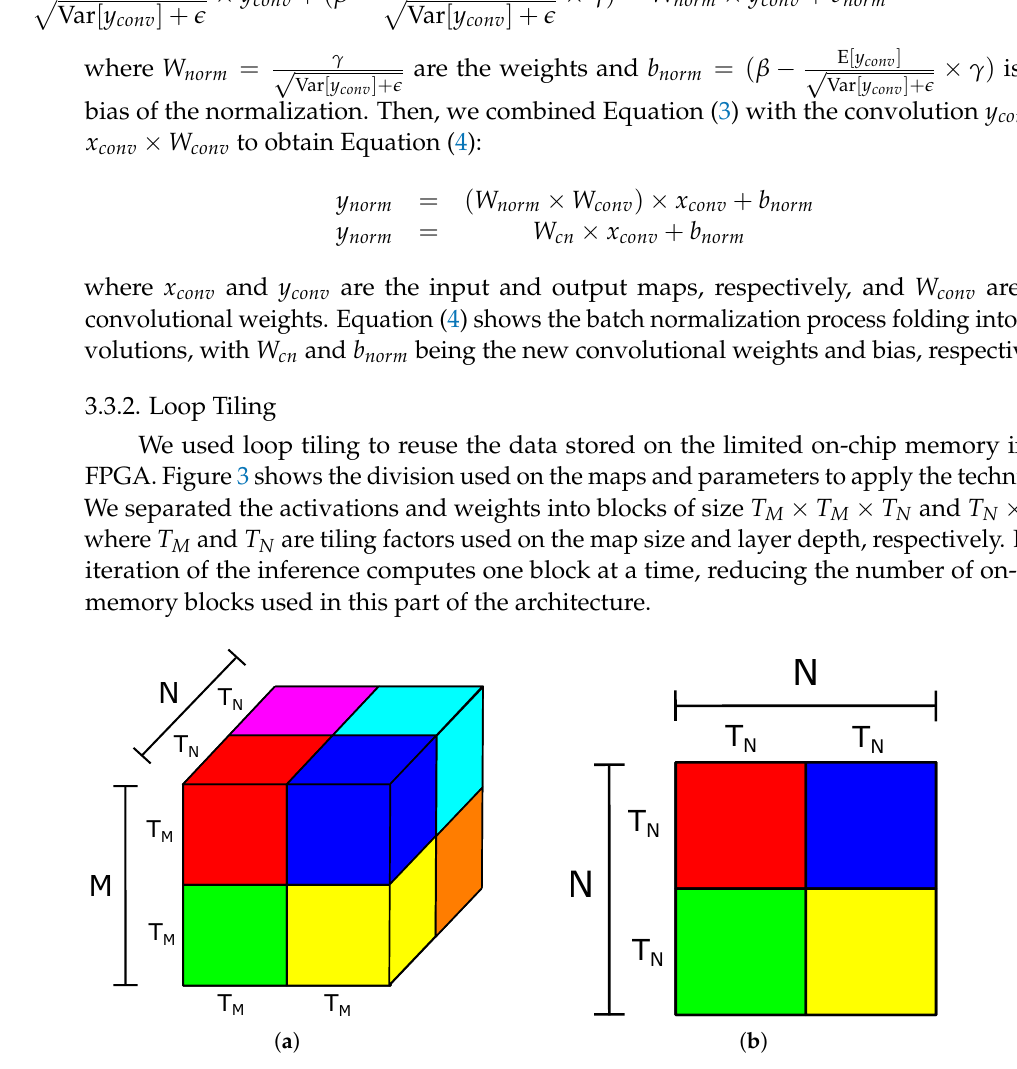
Figure 3. ( a ) Loop tiling in feature maps; ( b ) loop tiling in